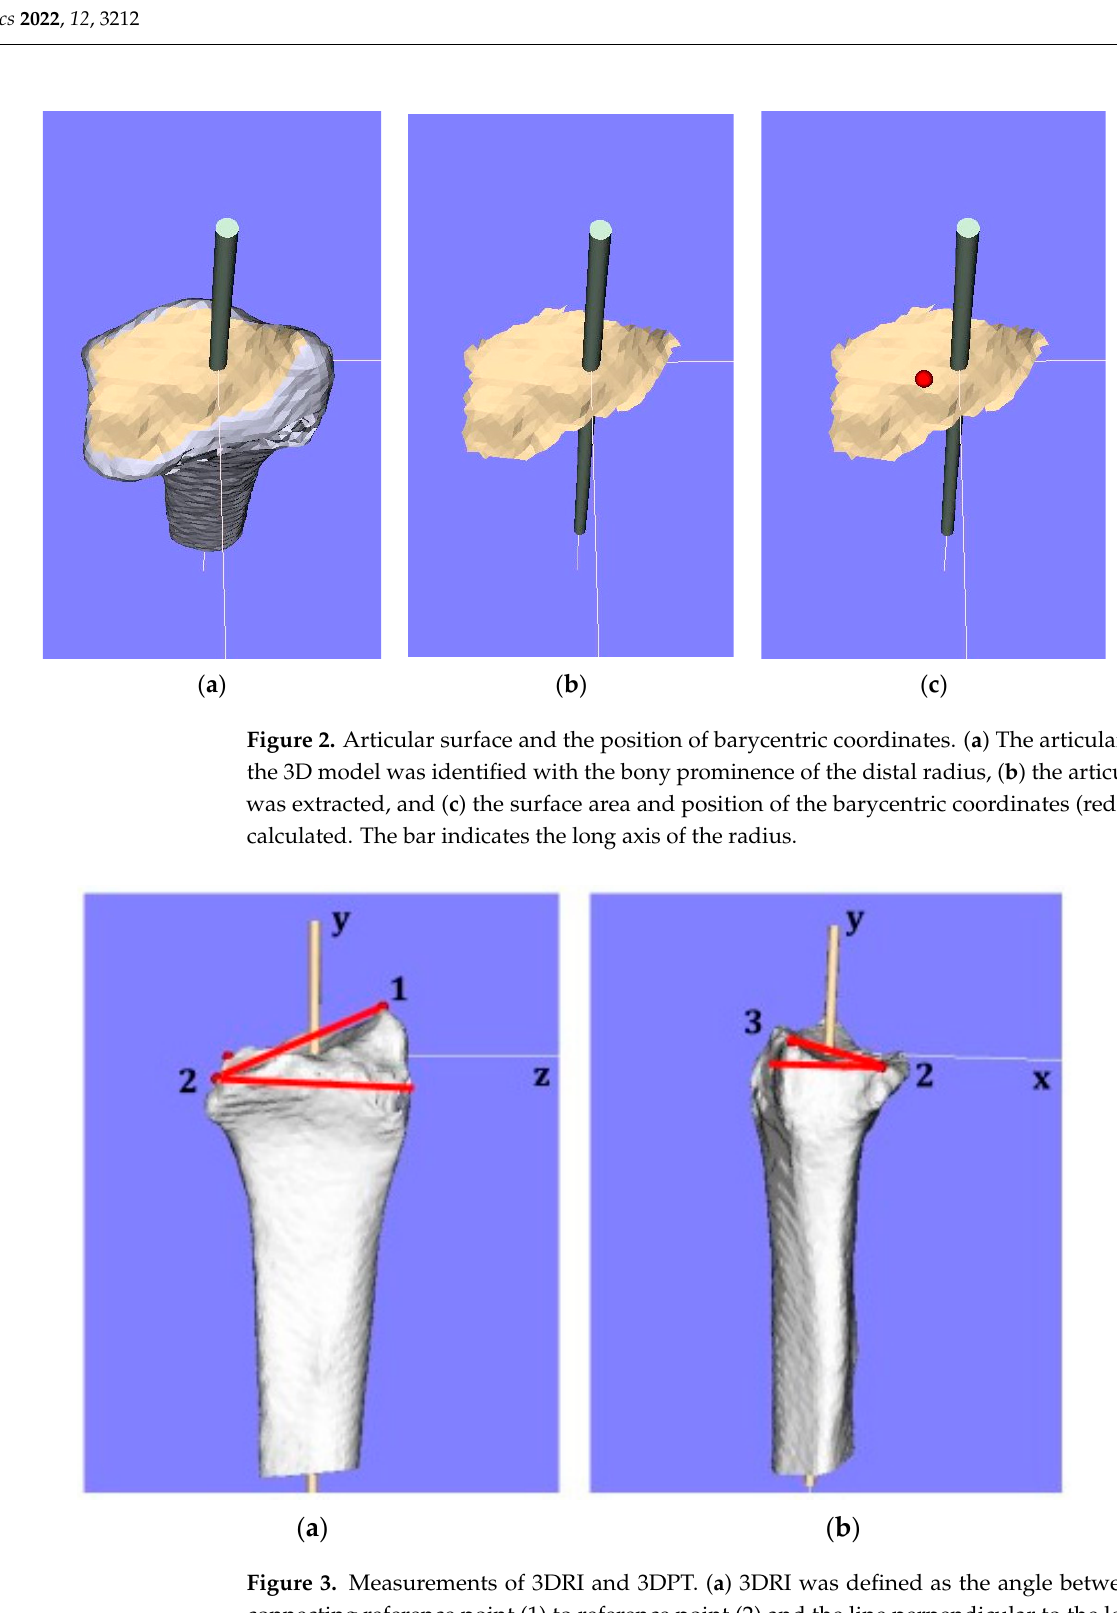
Figure 3. Measurements of 3DRI and 3DPT. ( a ) 3DRI was defined as the angle between the line connecting reference point (1) to reference point (2) and the line perpendicular to the longitudinal axis of the radius. ( b ) 3DPT was defined as the angle between the line connecting reference point (2) to the reference point (3) and the line perpendicular to the longitudinal axis of the radius. Red lines show the angles for the 3DRI and